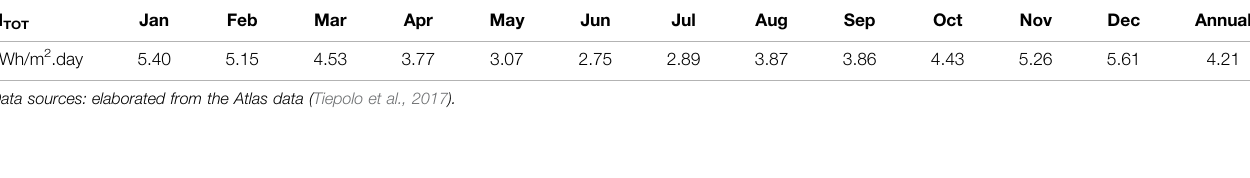
TABLE 1 | Horizontal global irradiation data from the Paraná State Solar Energy Atlas.